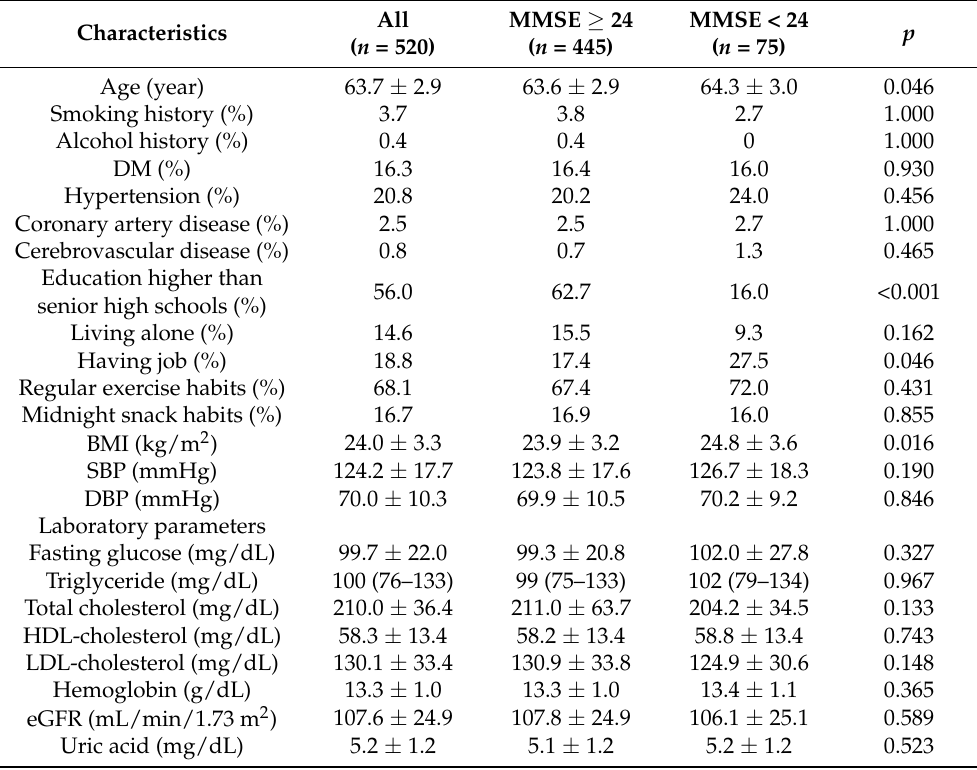
Table 1. Comparison of clinical characteristics among participants according to total Mini Mental State Examination (MMSE) scores ≥ 24 or <